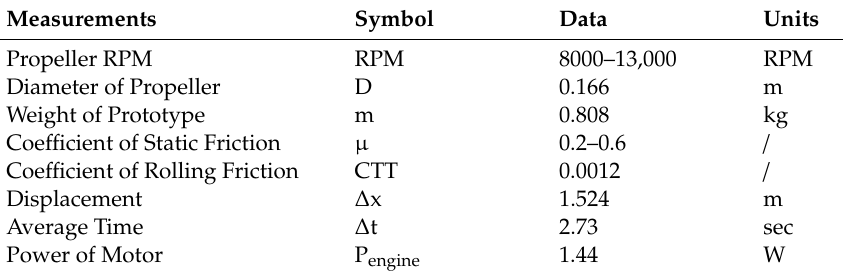
Table 1. Measurements and